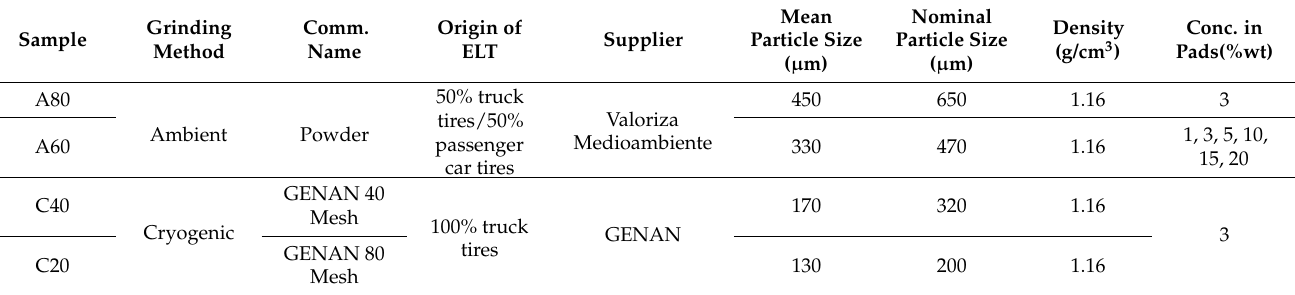
Table 2. Characteristics of the ELT rubber samples used in this